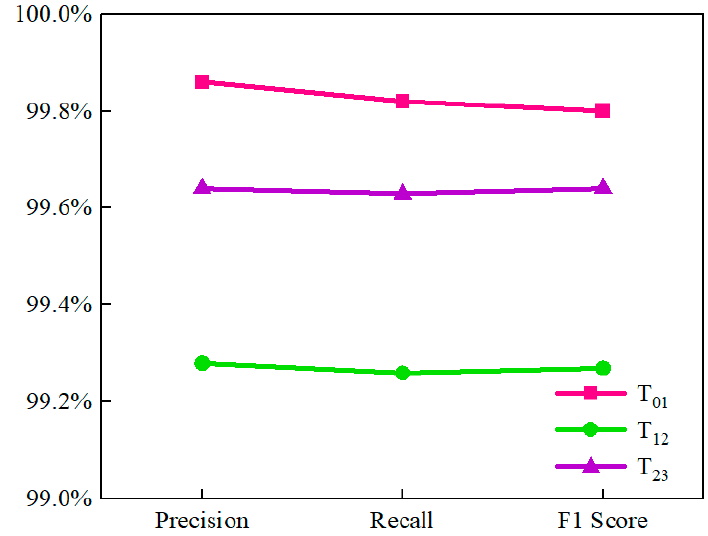
Figure 10. Training accuracy and loss curves.